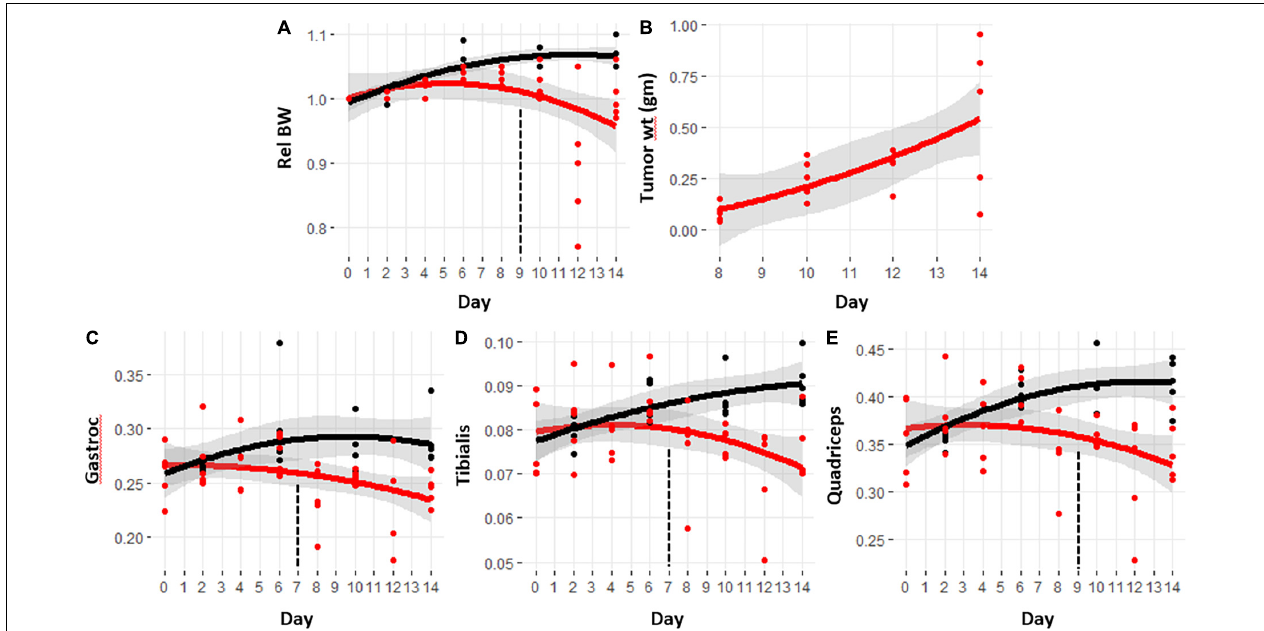
FIGURE 1 | Trajectories of body weight, tumor size, and skeletal muscle masses with the progression of cancer-induced cachexia. Trajectories are calculated using a quadratic function with gray bands indicating the 95% confidence interval for the fit. Black lines are from control mice and red lines are from tumor hosts. Vertical dashed lines indicate the day in which the trajectories became significantly different. The p -values for this data are provided in Supplementary Table 1 . (A) Relative body weight, (B) tumor size measured at sacrifice, (C–E) weights of gastrocnemius, quadriceps, and tibialis respectively, taken at